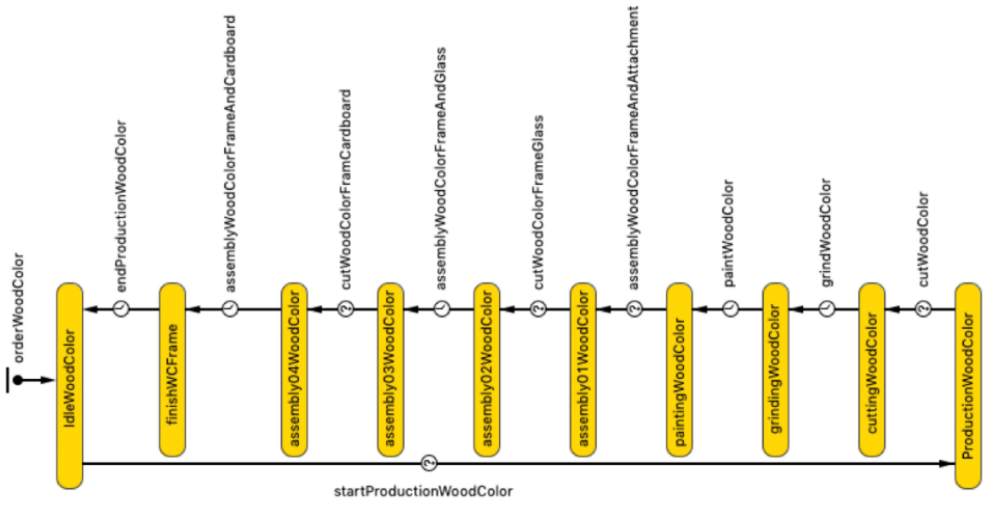
Figure 4. Transition, Software: